Question: Name the type of graph shown.
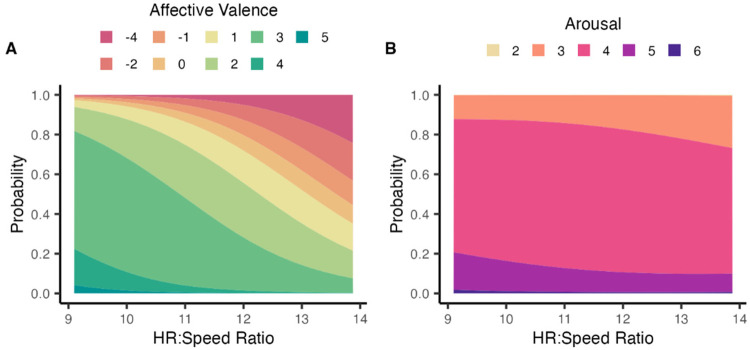
Answer: line